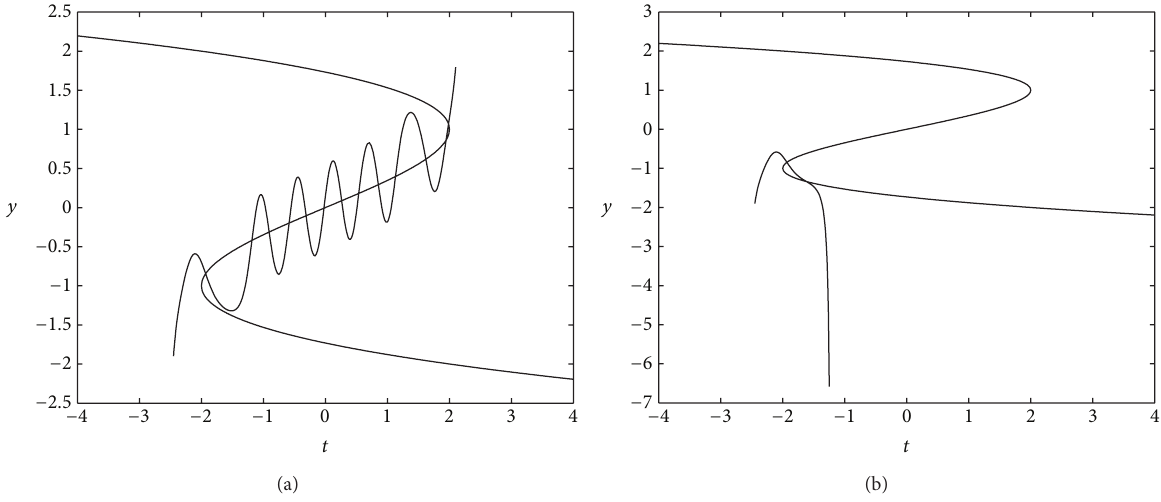
and 𝑡 ∗ = 𝑡 ,respectively. SC 1 SC 2